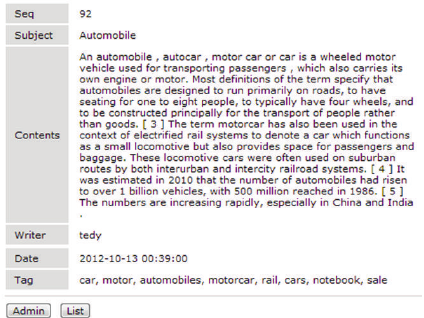
Figure 7: User input screen (tags are completed in the bulletin board).